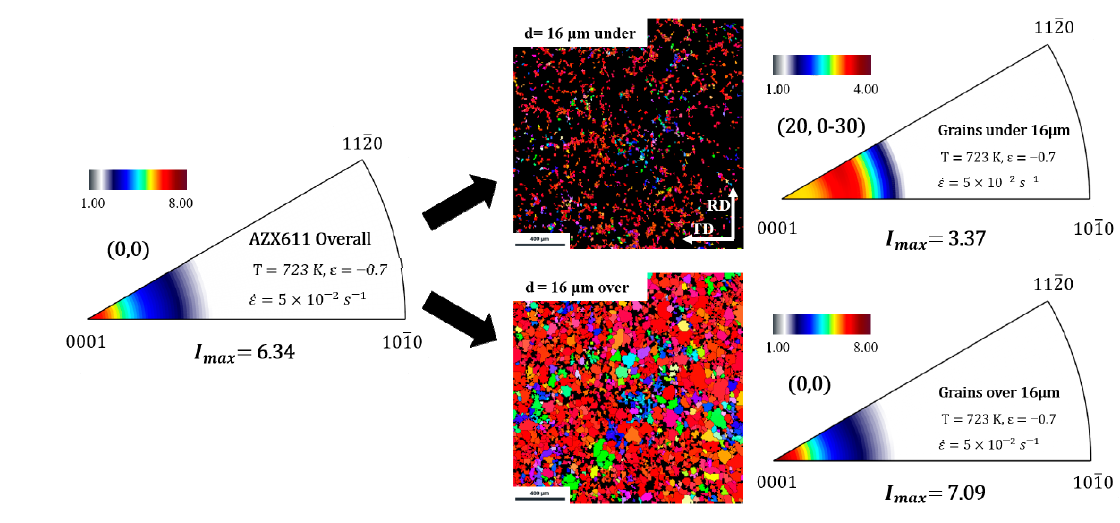
Figure 10. IPF of AZX611 deformed specimens after the strain − 0.7. Each IPF shows the texture of grains overall and separated along with the grain size.